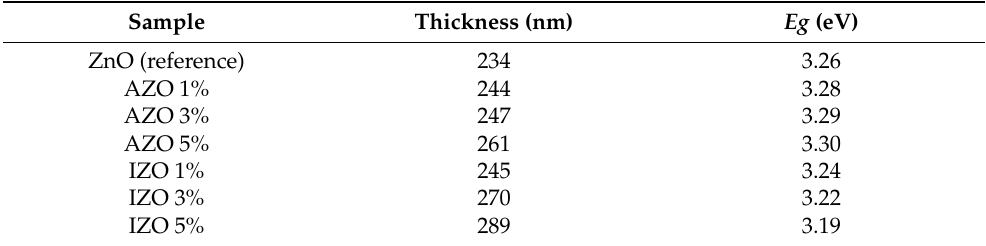
Table 3. The thickness and the calculated energy gap of undoped ZnO, AZO, and IZO thin films.